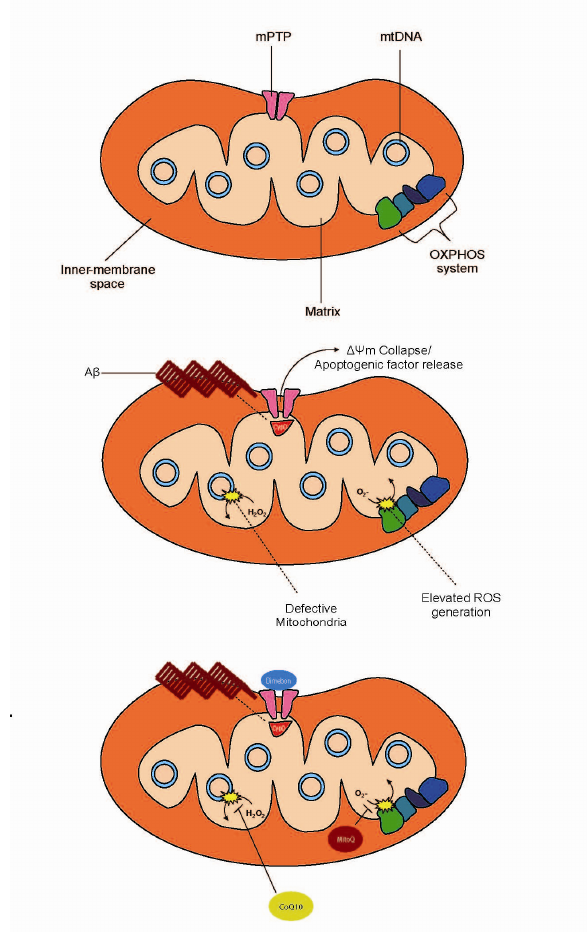
Figure 1. (A) A mitochondrion with intact components typical of healthy brain: functional oxidative phosphorylation (OXPHOS) system, non-mutated mtDNA, closed,